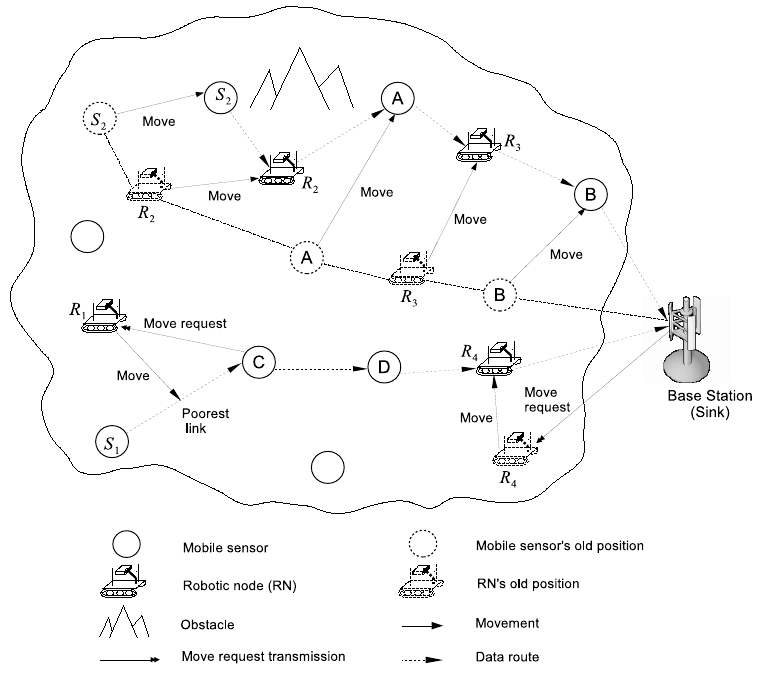
Figure 1. An example of mobile sensor network with robotic